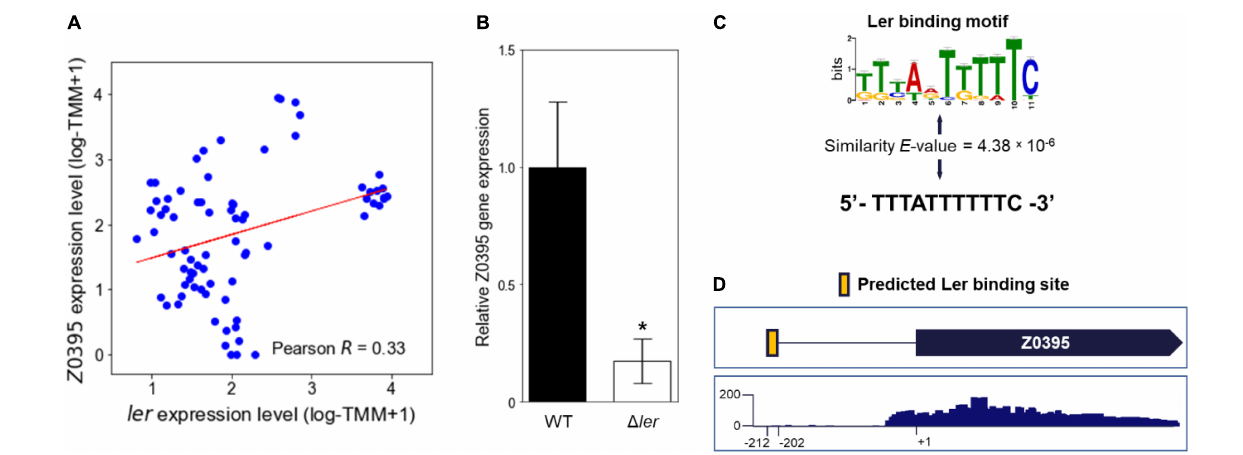
FIGURE 2 | The Z0395 gene is a member of the Ler regulon. (A) The scatter plot of the expression levels of the Z0395 gene and ler . Each dot of the plot represents a single biological replicate. Red line represents the regression line of the plot. The Pearson R value between the expression levels of the Z0395 gene and ler is denoted in the box. (B) The relative expression levels of the Z0395 gene in the WT and ler deletion mutant. The levels of the Z0395 gene transcripts were determined by qRT-PCR, and the Z0395 gene transcript levels in the WT were set to 1. Error bars represent the SD from four independent experiments. Statistical significance was determined by the Student’s t -test (* P < 0.05). WT, EDL933; (cid:49) ler , ler deletion mutant. (C) The Ler binding motif depicted in the logo and the Ler binding sequence predicted in silico found at the Z0395 gene upstream region. The height of the letters in the logo represents the information contents of the position in bits. The similarity between the Ler binding motif (top) and the predicted binding sequence (bottom) are denoted as E -value. (D) Location of the Ler binding sequence in silico predicted in the Z0395 gene upstream region. The Ler binding sequence is located from –212 to –202 region of the Z0395 ORF, represented as a yellow box. The bellow box represents the coverage plot of the reads mapped to the Z0395 gene. The transcriptome data of EHEC EDL933 grown in M9 minimal medium were used to generate the plot. The y -axis represents the normalized number of reads per base. The average number of reads of the biological triplicates are shown in the plot.